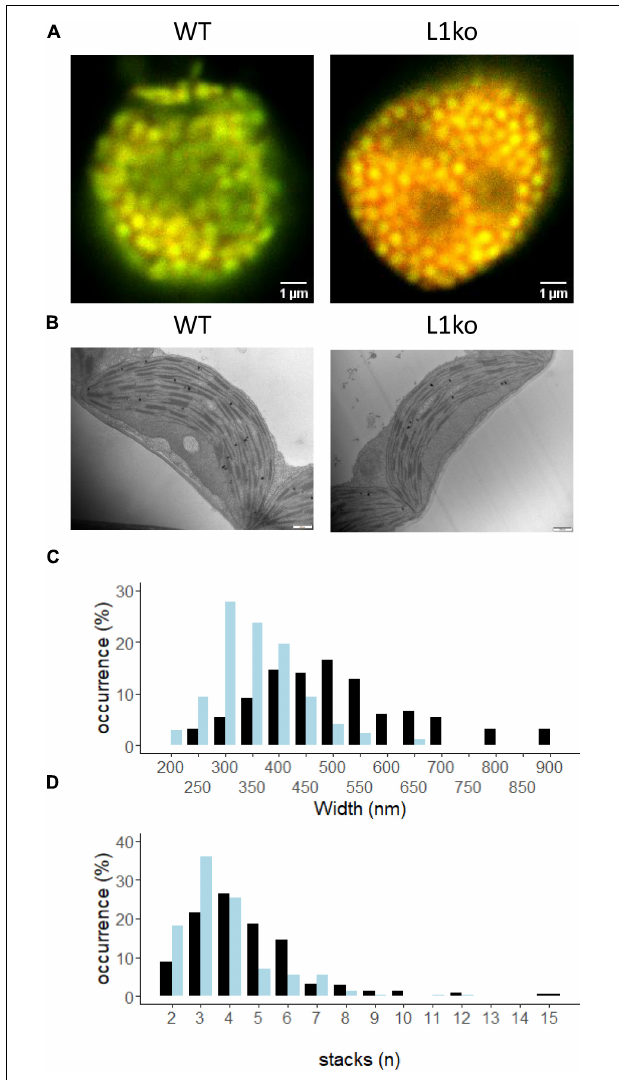
FIGURE 6 | LHCB1 mutation affects the thylakoid structure. (A) Confocal microscopy on isolated chloroplasts of WT and L1ko. Excitation at 633 nm and detection at 650–680 nm are shown in green (PSII-maximum), while 710–750 nm detection in red (PSI-maximum). Red channel intensity has been increased 10 times in comparison to the green channel to compensate for decreased sensitivity of the detector and decreased fluorescence emission in the far-red region (see Supplementary Figure 10 ). (B) Representative images of chloroplasts from WT and L1ko leaves obtained by transmission electron microscopy. The scale bar is 500 nm (see Supplementary Figure 12 ). (C) Distribution of the grana width in WT and L1ko based on the measurement of 164 and 173 grana for WT and L1ko, respectively. (D) Distribution of the grana stacks divided by the number of layers based on the analysis of 215 and 241 grana for WT and L1ko, respectively. The chloroplast images used for the analysis were obtained from two independent biological samples. The statistical analysis of the grana stack number and width distributions is presented in the text.